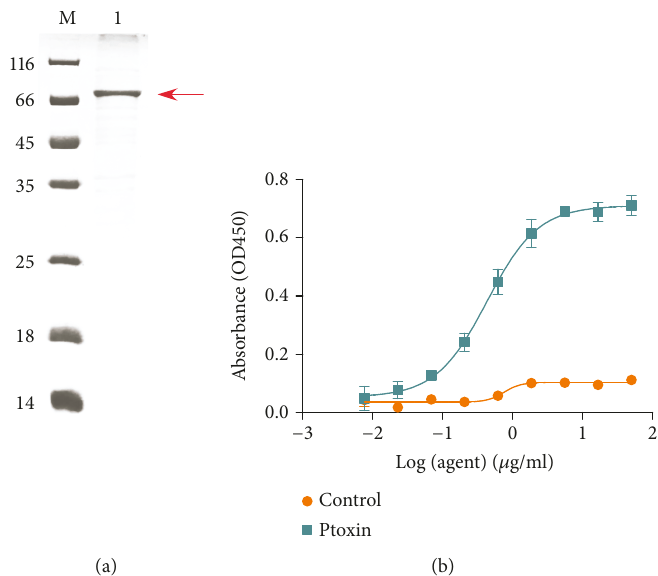
Figure 1: Characterization of Ptoxin. (a) SDS-PAGE analysis of Ptoxin. Lane 1: Ptoxin; M: protein marker. (b) ELISA analysis of Ptoxin- binding potency for recombinant EGFR antigen. EC50 for Ptoxin is 0.4304 μ g/mL (95% con fi dence interval (CI): 0.3571-0.5189 μ g/mL). IgG was used as control. Points: mean of 3 independent determinations; bars: